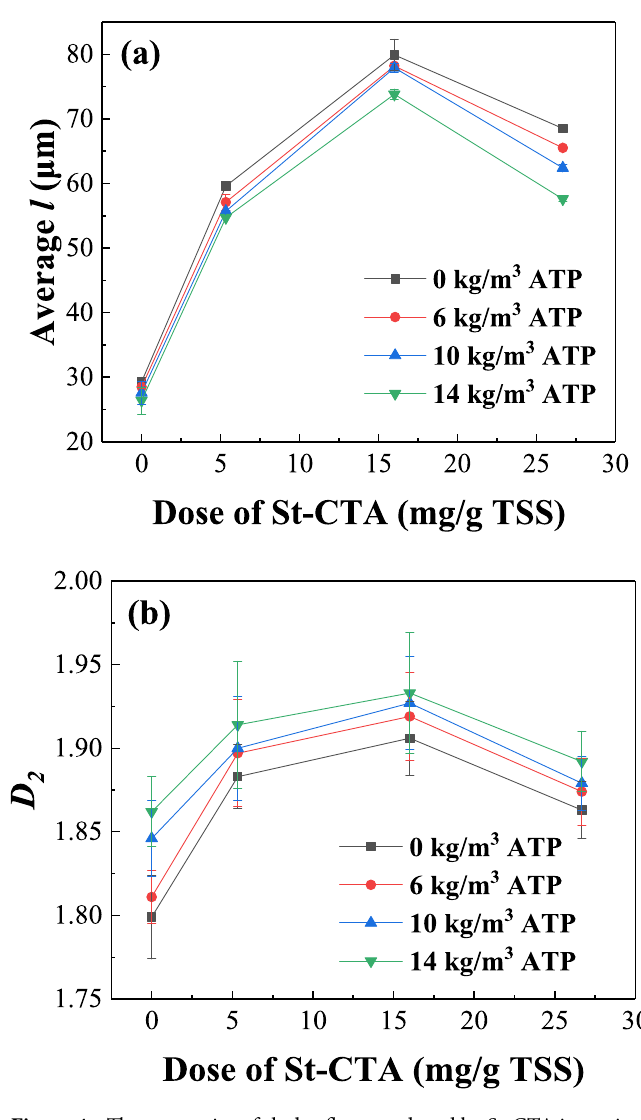
Figure 4. The properties of sludge flocs produced by St-CTA in conjunction with ATP using different doses: ( a ) Average floc size ( l ) and ( b ) 2D fractal dimension ( D 2